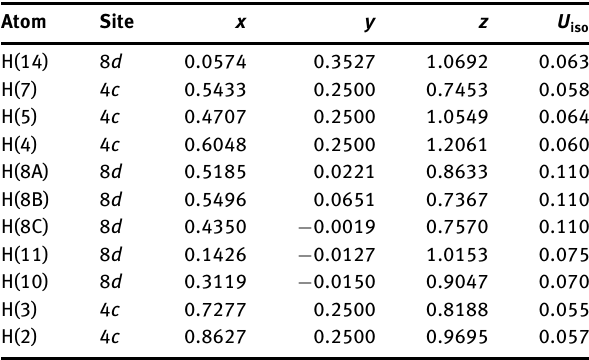
Table 2: Fractional atomic coordinates and isotropic or equivalent isotropic displacement parameters (Å 2